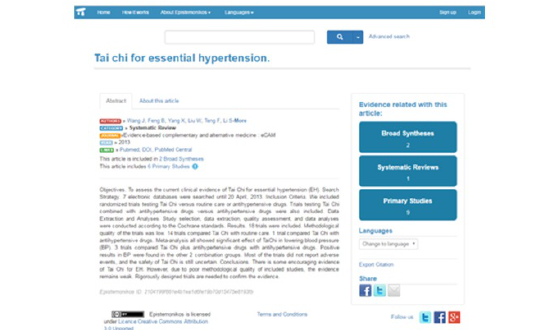
Figure 1 Article from search results for “Tai chi for essential hyperten-